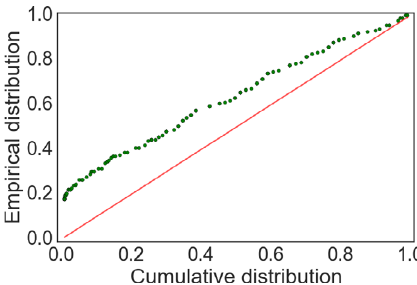
Fig. 3. Quantile – quantile plot of the empirical cumulative distribution (dotted) vs. the cumulative distribution of a uniform random variable (solid line). We can see that there is a clear deviation of the data from the straight line before applying the bias removal algorithm.